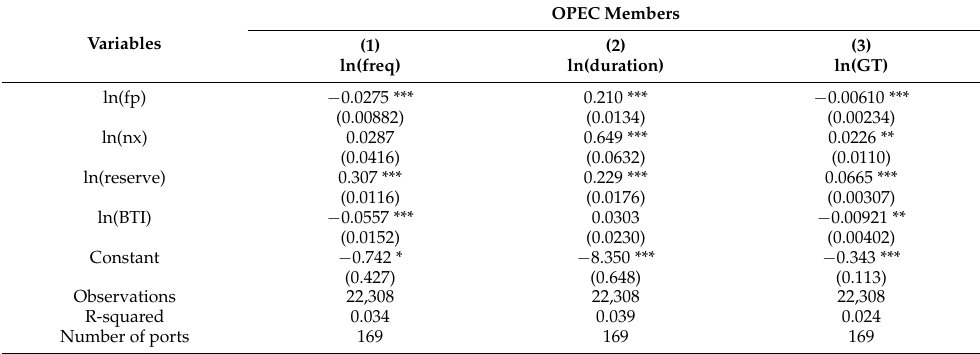
Table 10. Robustness test: OPEC